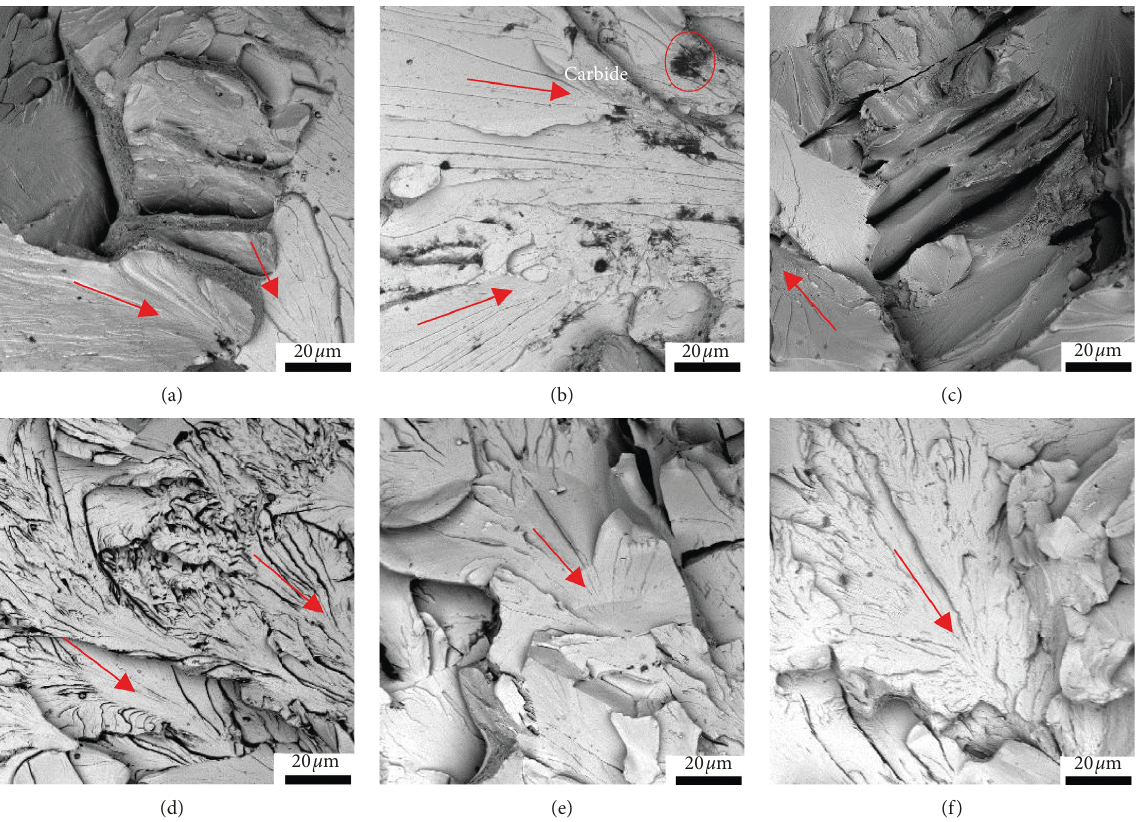
Figure 10: The fracture morphology of tensile specimens: (a) the conventional ingots at position R ; (b) the conventional ingots at position 1/2 R ; (c) the conventional ingots at position 0 R ; (d) the ultrasonic ingots at position R ; (e) the ultrasonic ingots at position 1/2 R ; (f) the ultrasonic ingots at position 0 R